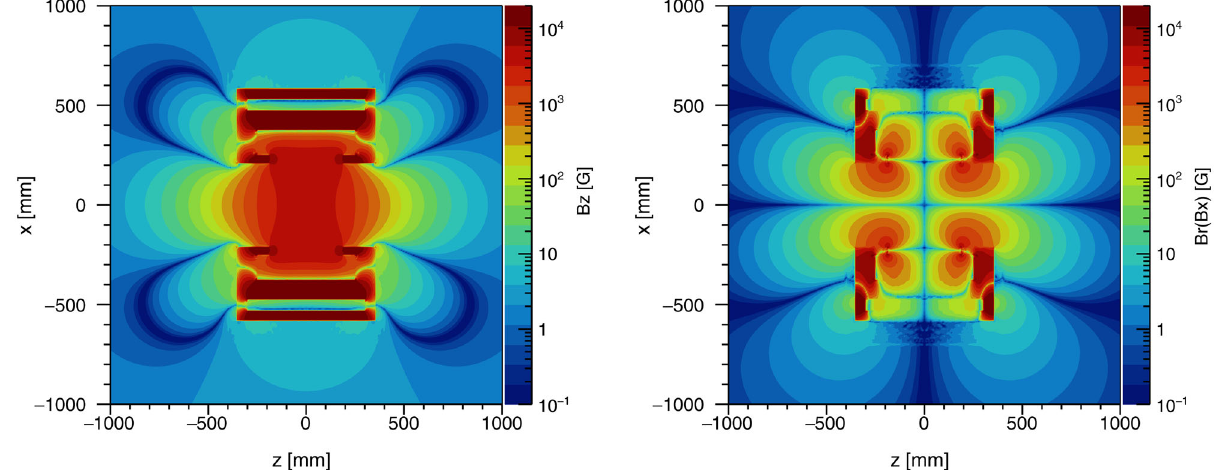
FIG. 19. Contour map of B z =B r on the XOZ plane of the model-3 WSY.